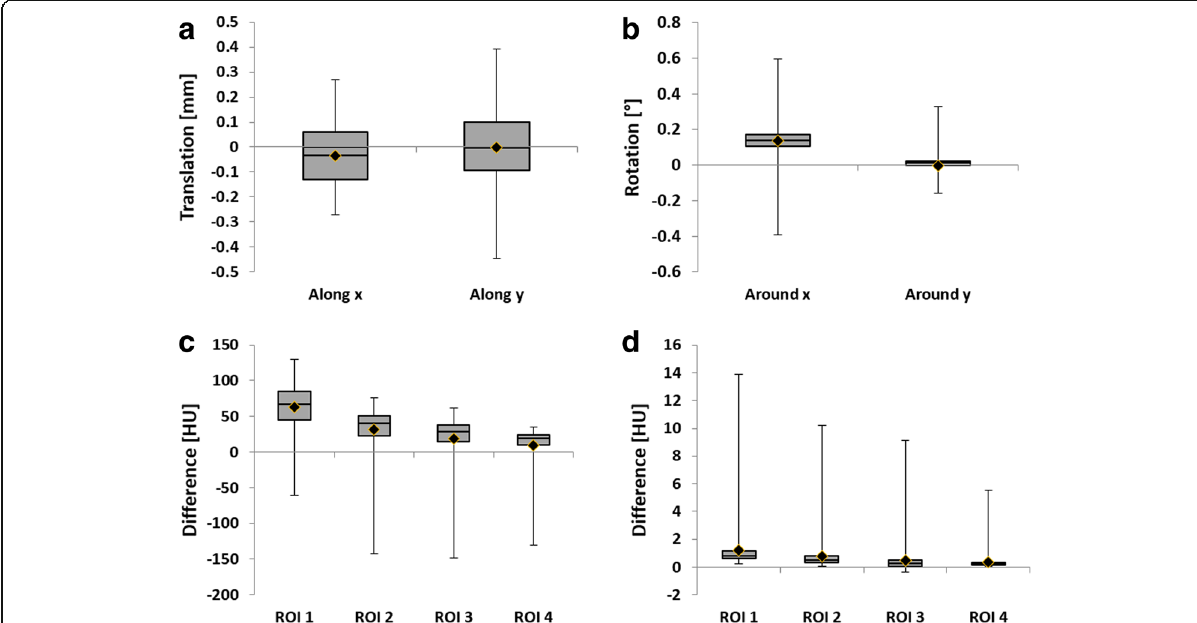
Fig. 5 Results of the phantom evaluation of algorithmically determined parameters versus ground truth. Boxes indicate upper and lower quartile and median, diamonds indicate mean, and maximum and minimum are indicated by whiskers. a Difference in translation. b Difference in rotation. c Difference in CT numbers measured in regions of interest (ROIs) before correction. d Difference in CT numbers measured in ROIs after correction. Note the different quantities and units and the different scaling of the y -axes